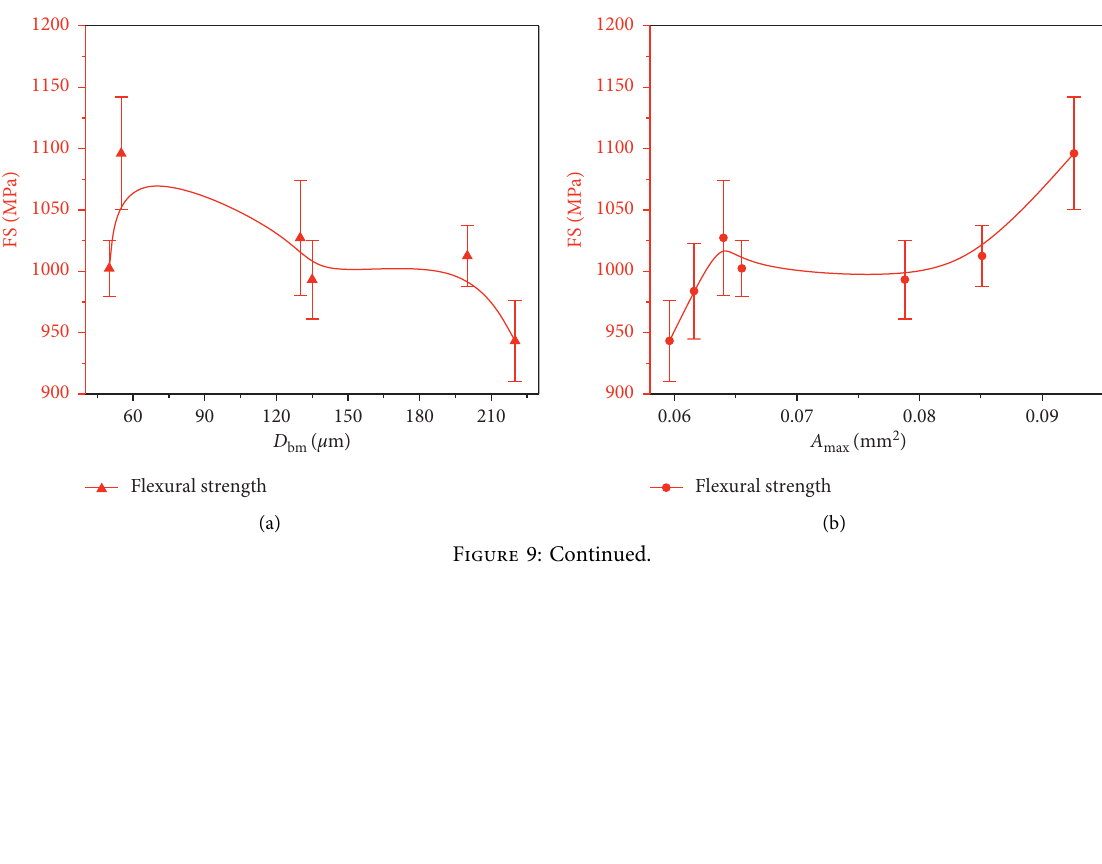
Figure 8: Relationship between void content and bubble characteristic parameters. (a) Bubble displacement ( D sectional area of the bubble ( A max ). (c) Void content and internal lowest temperature of the bubble ( T int ). (d) Maximum deformation of the fiber ( D fmax